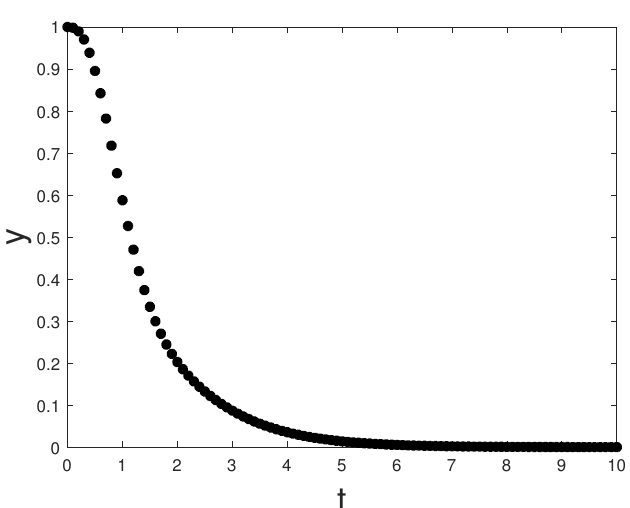
Figure 2. Numerical solution to problem (28) with h =